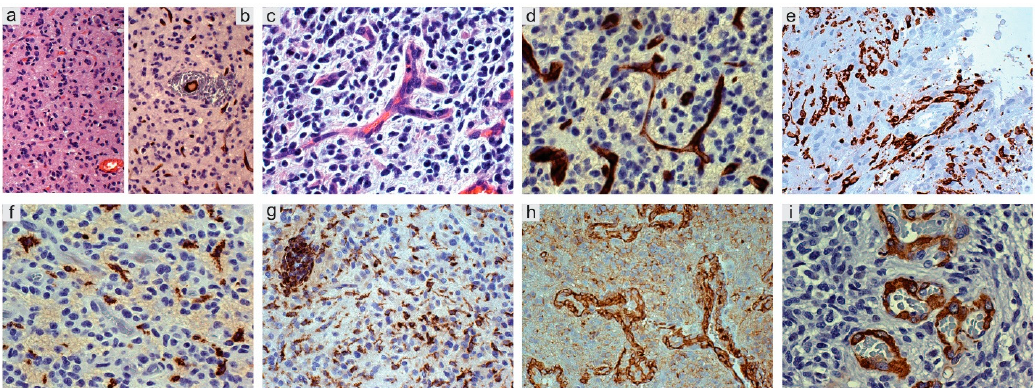
Figure 2. Glioblastoma, IDH wild type. ( a ) Mild infiltration with inital vessel increase; H&E, original magnification (OM) ×200. ( b ) Id ., CD34+ endothelial cells; DAB, OM ×200. ( c ) More advanced tumor infiltration, small vessel with endothelial proliferation and sprouts; H&E, OM ×400. ( d ) Id ., CD34+ endothelial cells; DAB, OM ×400. ( e ) Mild infiltration with perivascular macrophages; CD163, DAB, OM ×200. ( f ) Infiltration area with leaked perivascular macrophages; CD163, DAB, OM ×200. ( g ) Ramified microglia in tumor parenchyma and perivascular macrophages; Iba-1, DAB, OM ×200. ( h ) Proliferated tumor vessels with NG2/CSPG4+ endothelial cells and pericytes; DAB, OM ×200. ( i ) Glomeruli with α -SMA pericytes; DAB, OM ×200. IDH, isocitrate dehydrogenase; H&E, hematoxylin and eosin; DAB, DAB, 3,3 ′ - Diaminobenzidine .